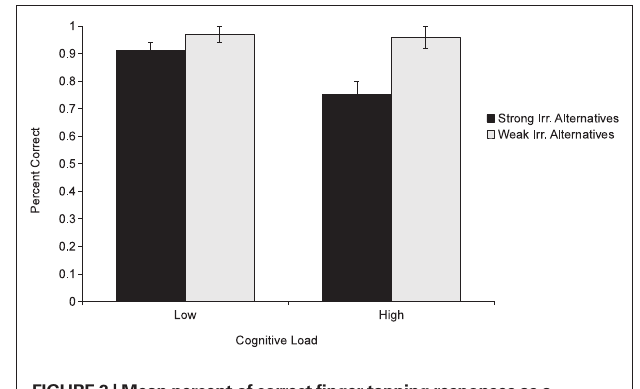
FiGure 3 | Mean percent of correct finger-tapping responses as a function of cognitive-load level in the divided attention task for experiment